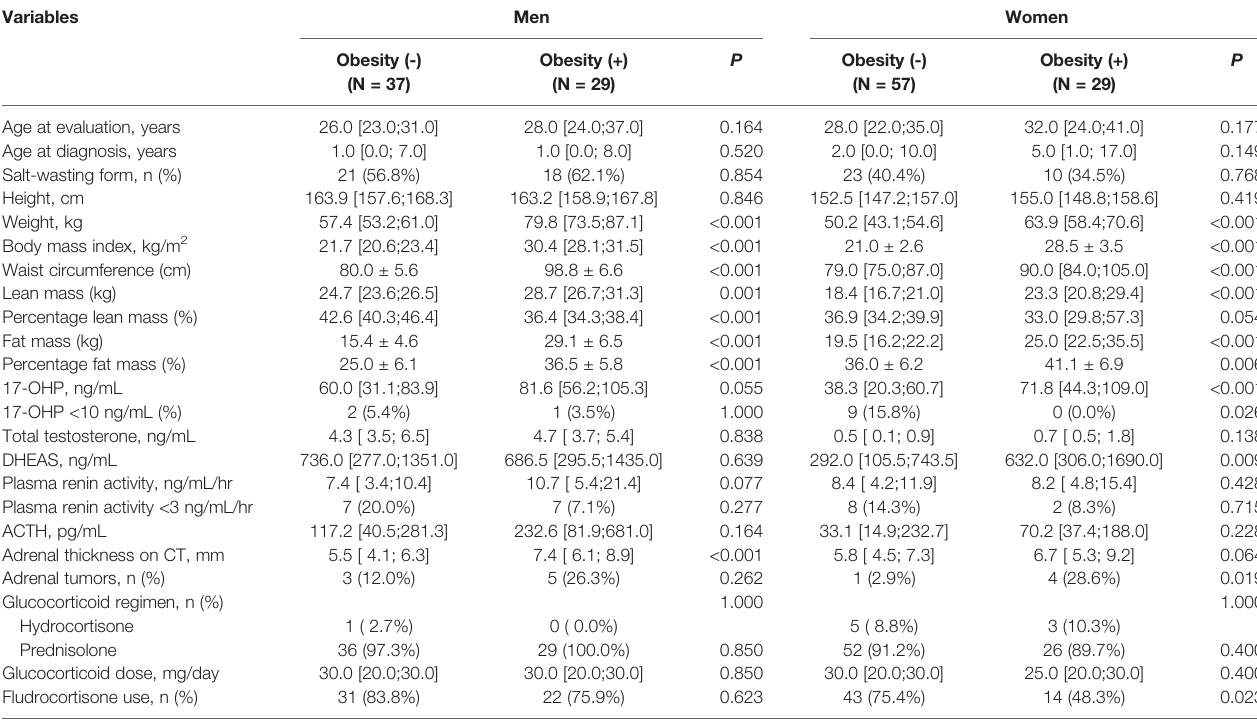
TABLE 3 | Hormone status and treatment regimens in CAH men and women according to the presence of obesity. Variables